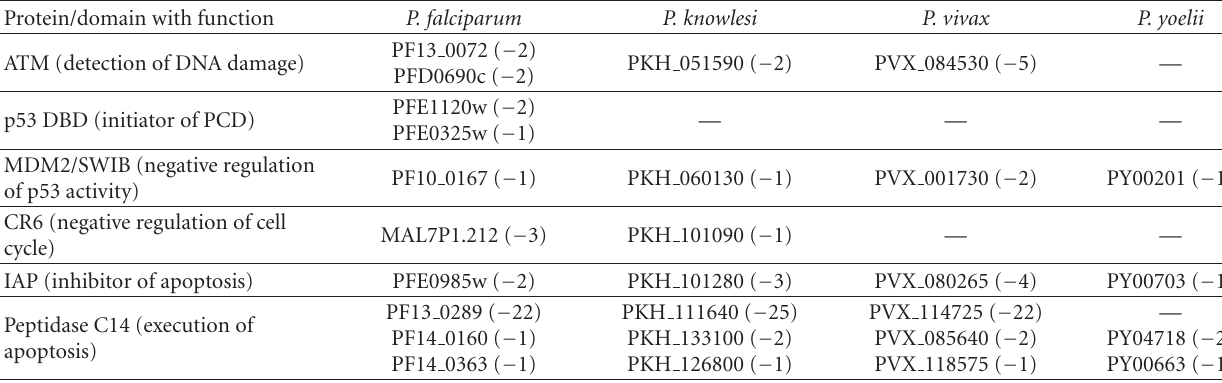
Protein/domain with